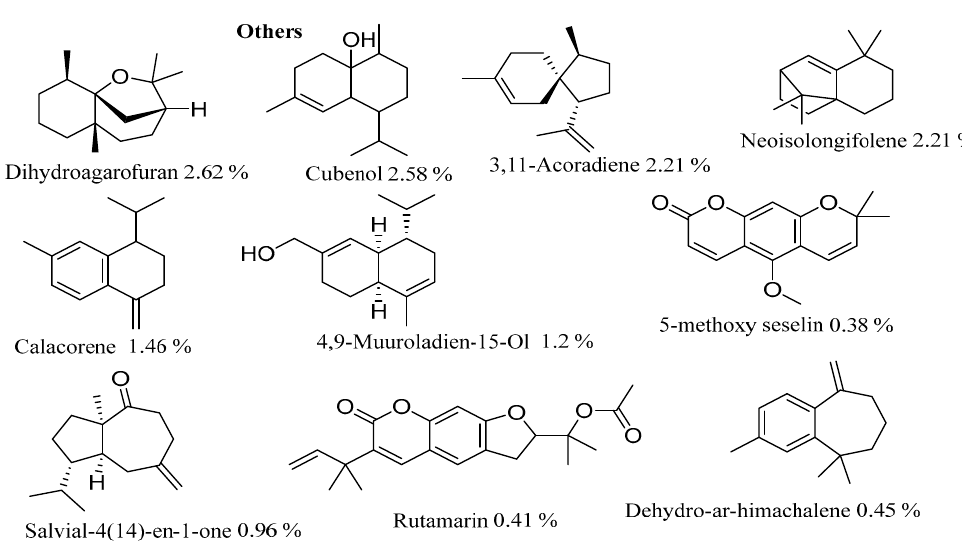
Figure 10. Structures of some of the major compounds reported for the first time in the volatile oil of T Ciliata.